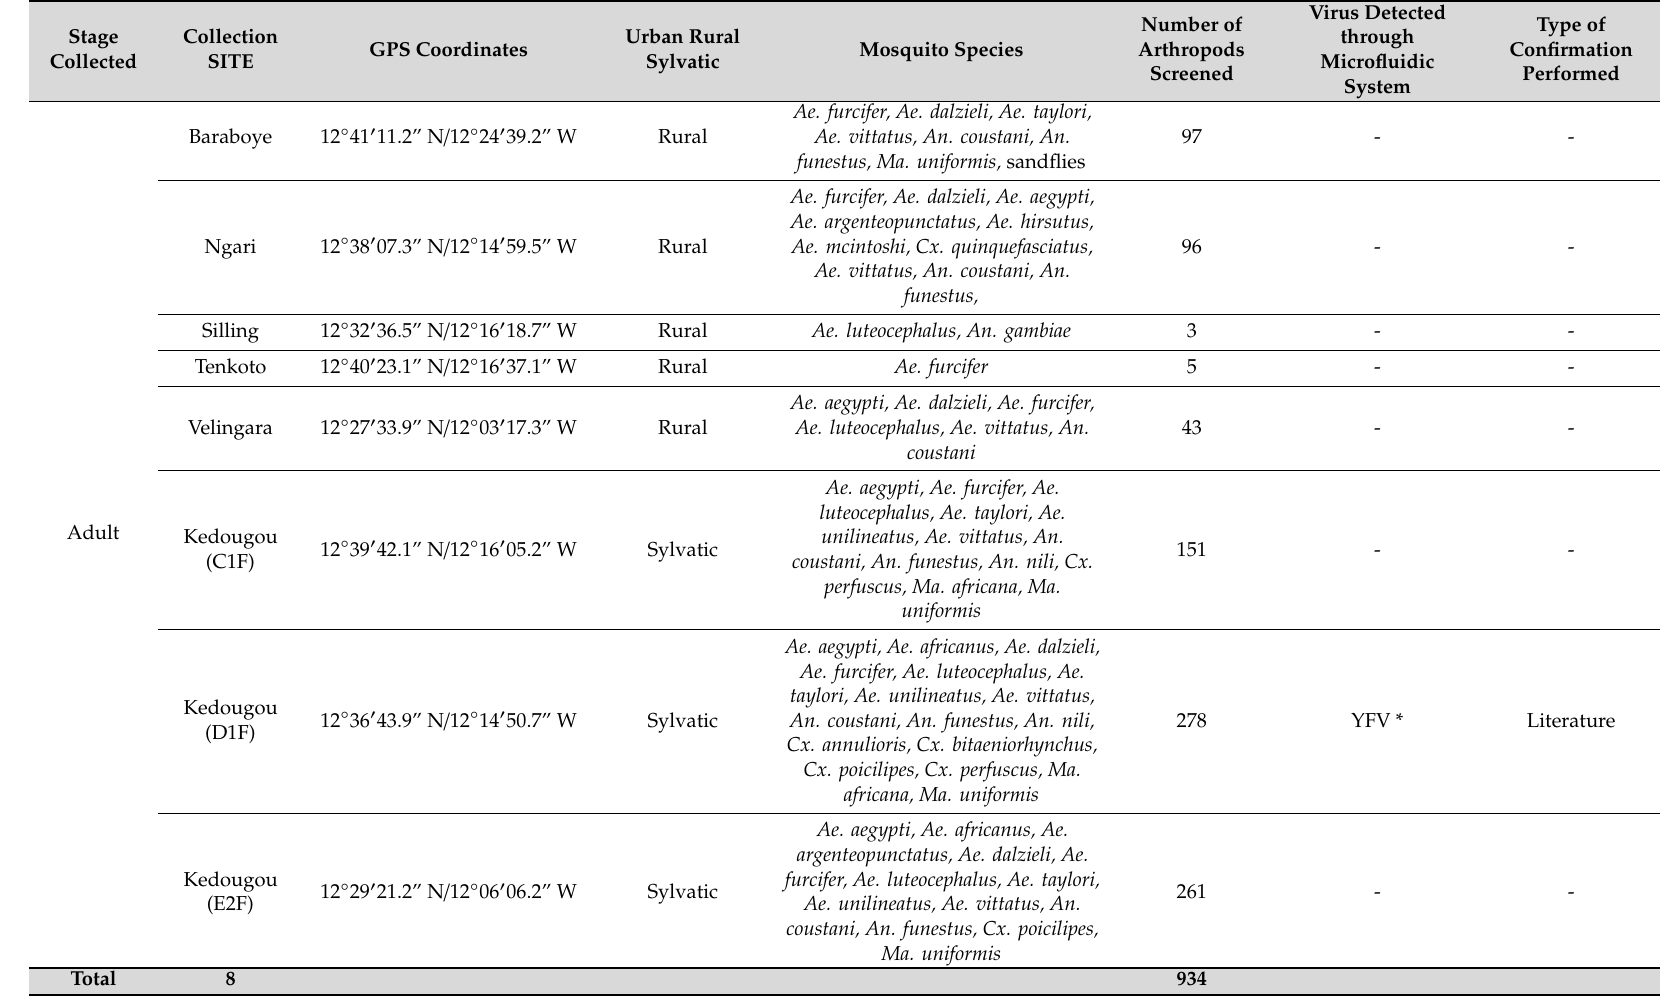
Table 1. Mosquito and sandflies species, number of mosquitoes collected, and number of pools analyzed in